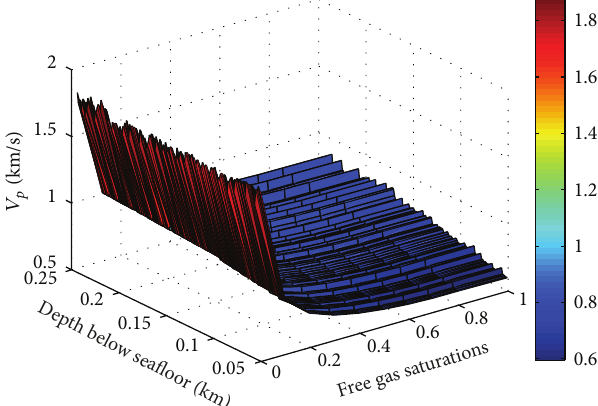
Figure 6: Relation between P wave velocity and sediment porosity, free gas saturation at site SH2. (P wave velocity is easily affected by the free gas saturation. When the free gas saturation increases, P wave velocity of forward stimulation by the free gas model of the TPT decreases